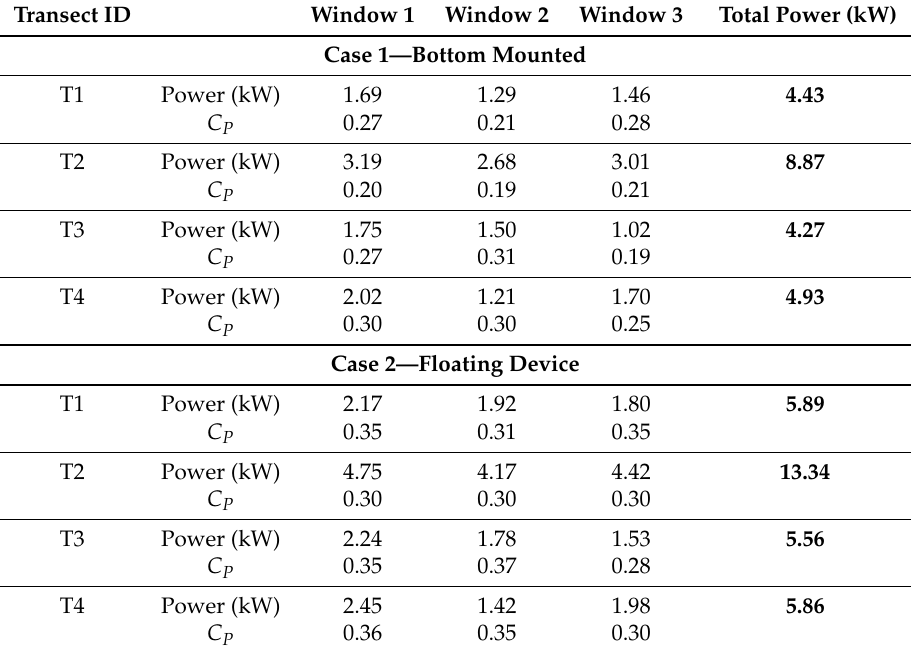
Table 3. Power output (P), power coefficients (C P ) and total theoretical power derived from BEM for each of the 10-m windows within the selected Transects T1–T4.